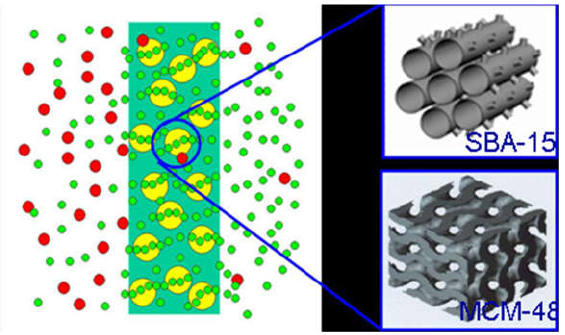
Figure 16. The structure model of ordered mesoporous silica/C hybrid CMS membrane [38].